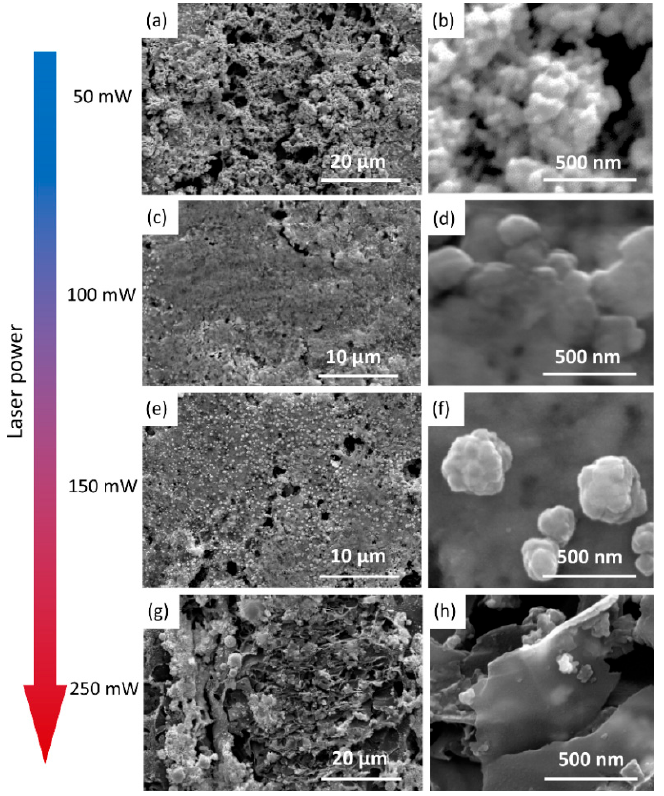
Figure 3. Scanning electron microscope images of laser-scripted silver membrane with different laser powers (( a ) and ( b ): 50 mW, ( c ) and ( d ): 100 mW, ( e ) and ( f ): 150 mW, ( g ) and ( h ): 250 mW).